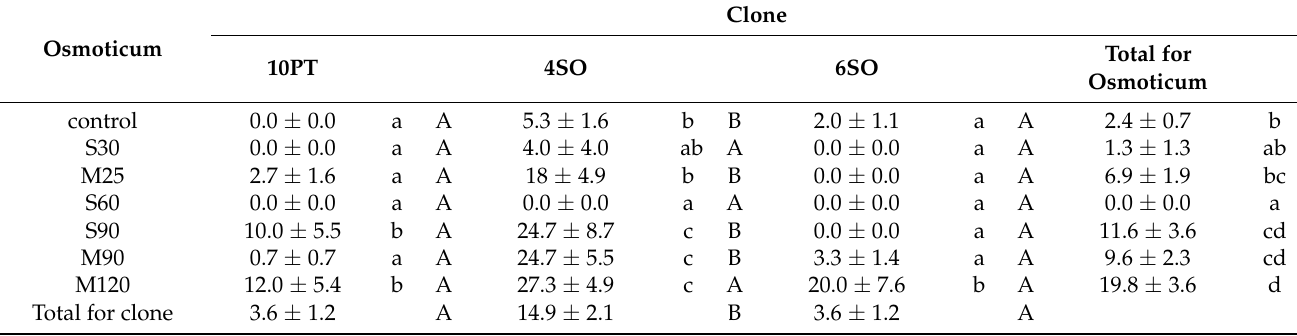
Table 4. Mean ± SE mortality rate (%) of R. pseudoacacia clones (10PT, 4SO, 6SO) after exposure to seven osmoticum treatments. Different treatments are denoted as: “control”—medium without